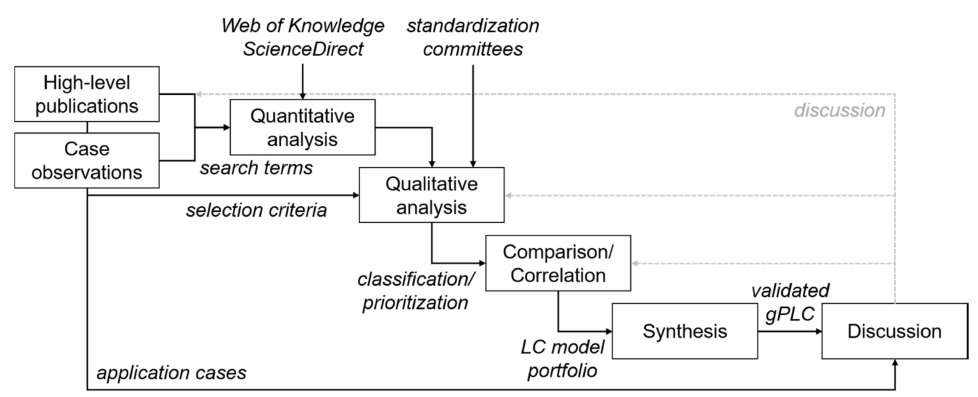
Figure 1. Literature-based research